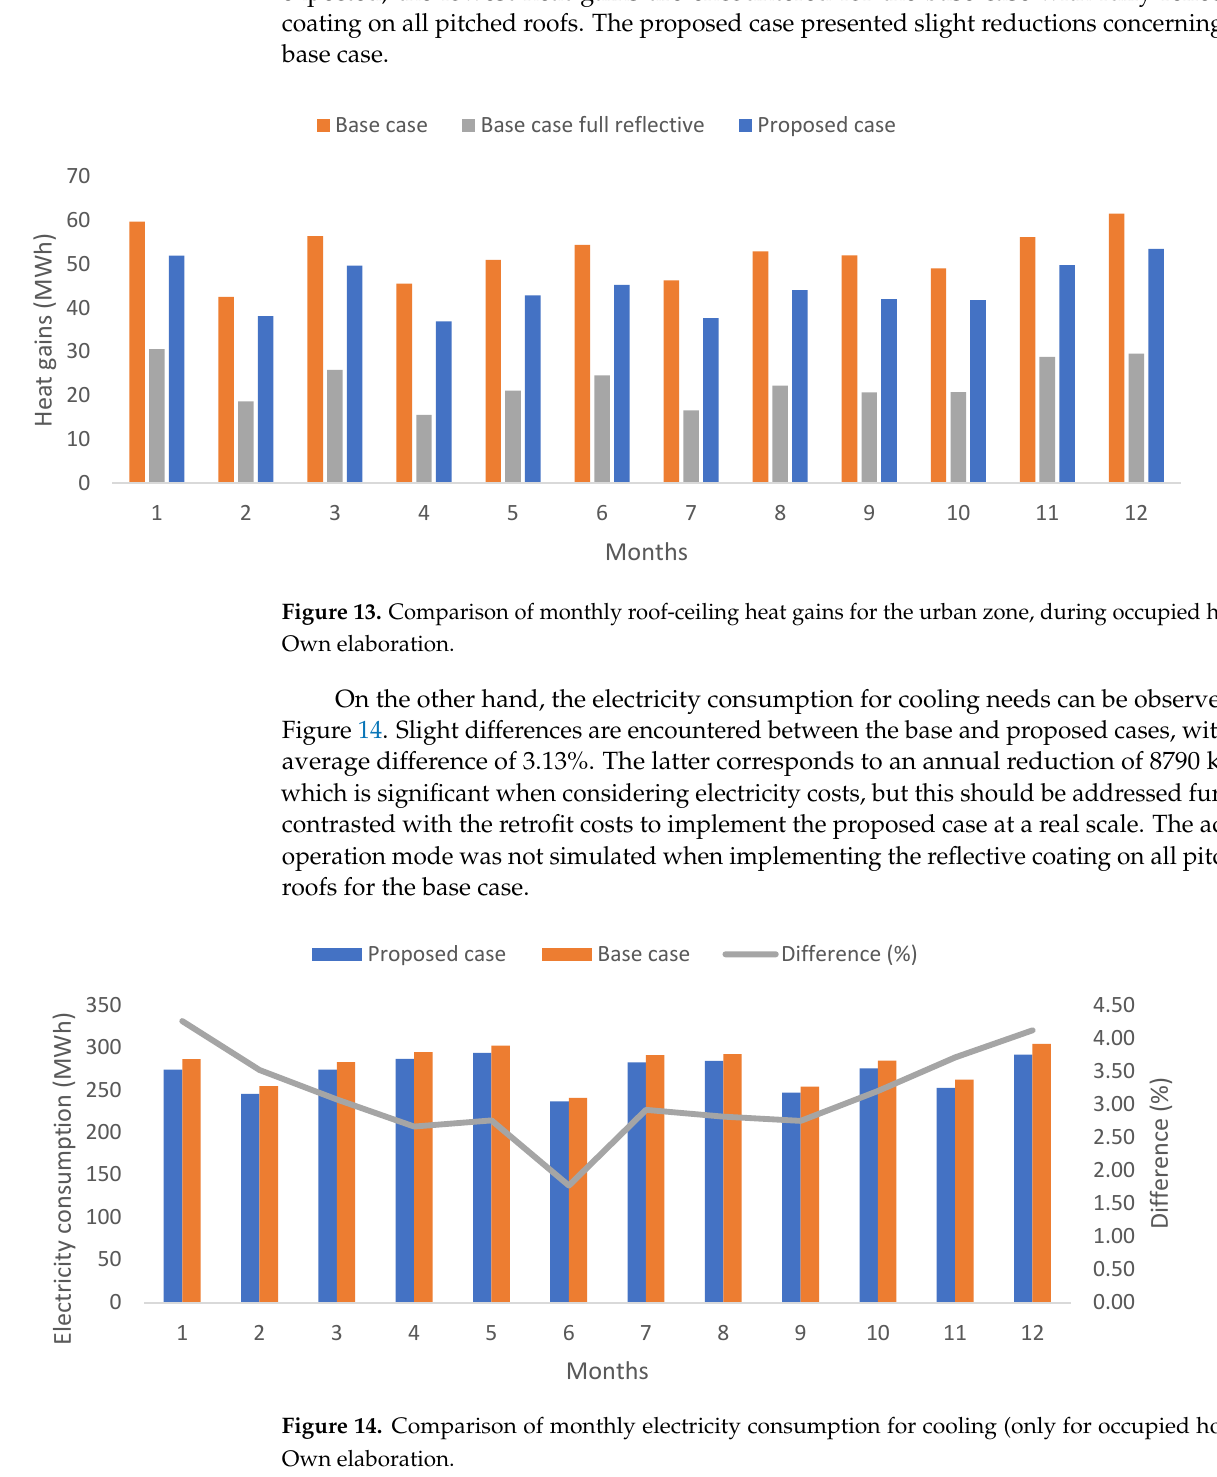
Figure 14. Comparison of monthly electricity consumption for cooling (only for occupied hours). Own